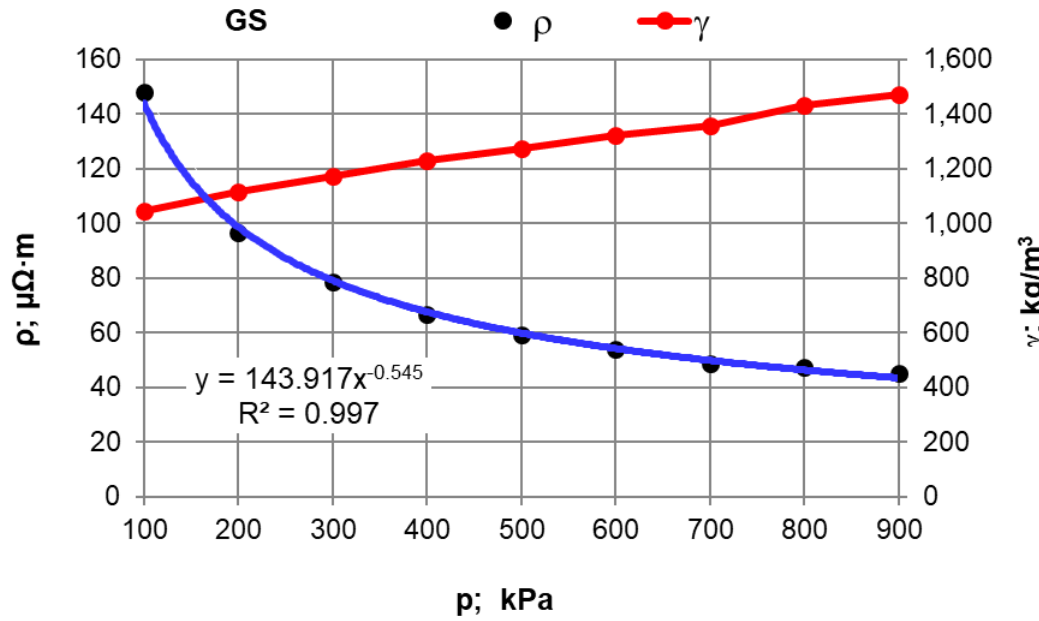
Figure 2. Resistivity and density versus the pressure value for the GS carburiser.